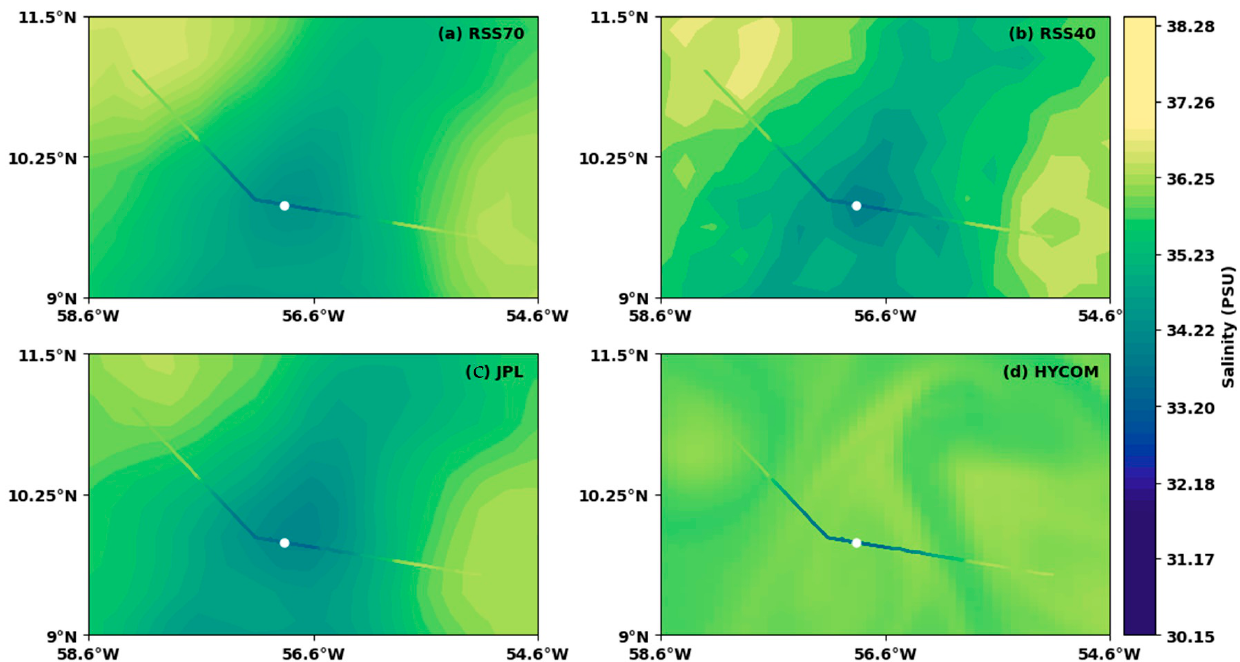
Figure 6. ( a ) Map of RSS70, ( b ) RSS40, ( c ) JPL and ( d ) HYCOM salinity for 8-day average centered on 17 February 2020 shown behind the 1026 saildrone vehicle’s SBE37 salinity data from the 16 Feb- ruary to the 20 February 2020. On 18 February 2020, the saildrone crossed the fresh tongue, the vehicle position indicated by white dot.